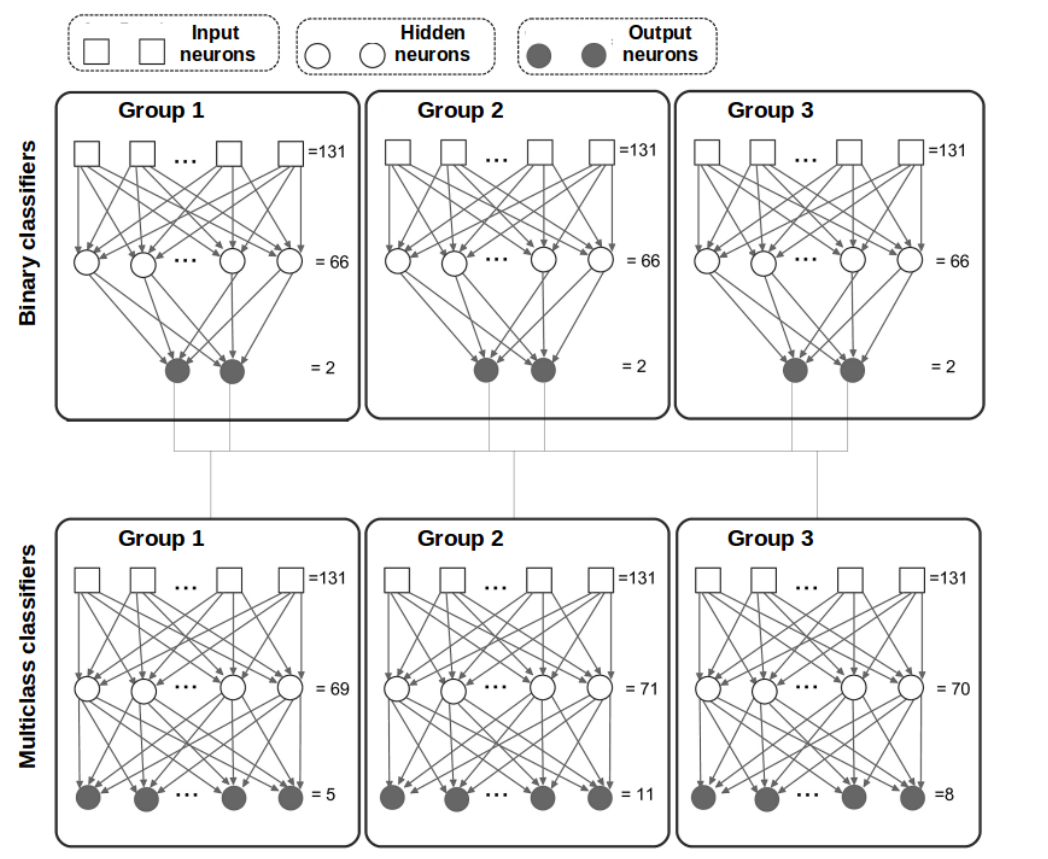
Figure 12. Achitecture of the ANN used in the 3 wide classes